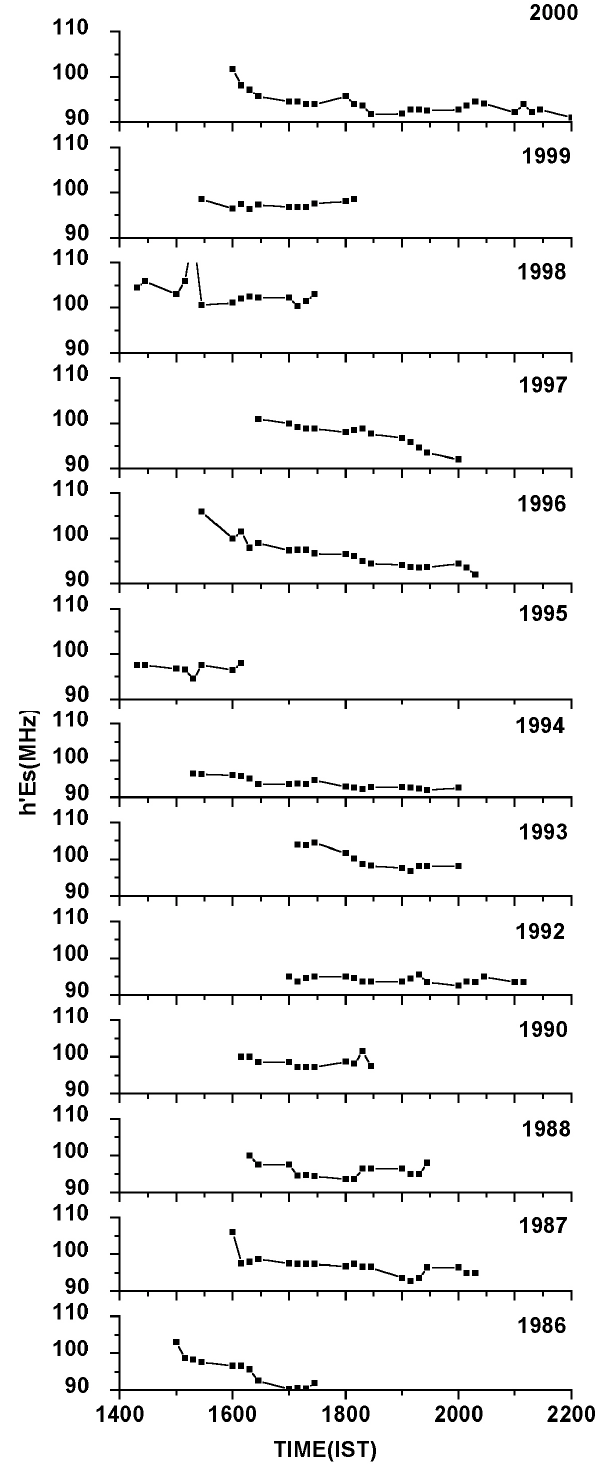
Fig. 8a. Time variation of f b E s corresponding to some strong E sb events during 1986–2000.